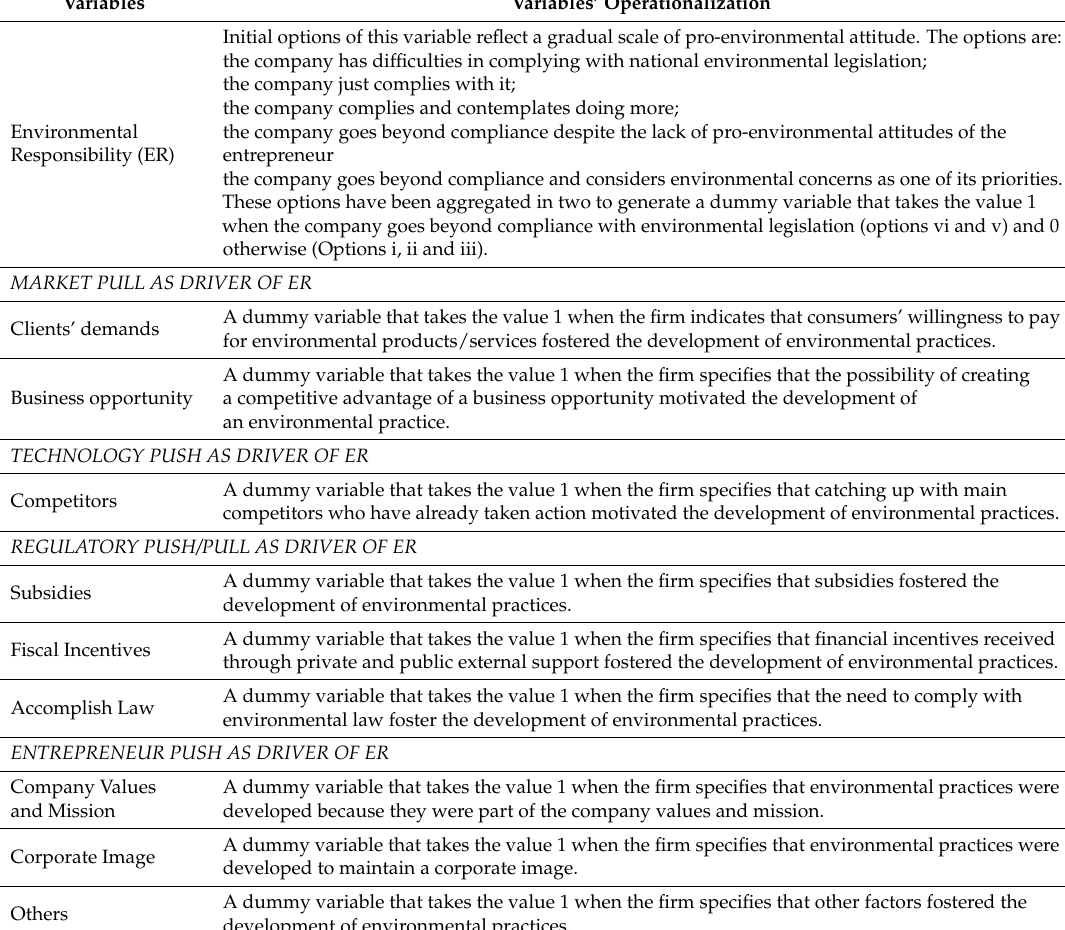
Table 1. Variables’